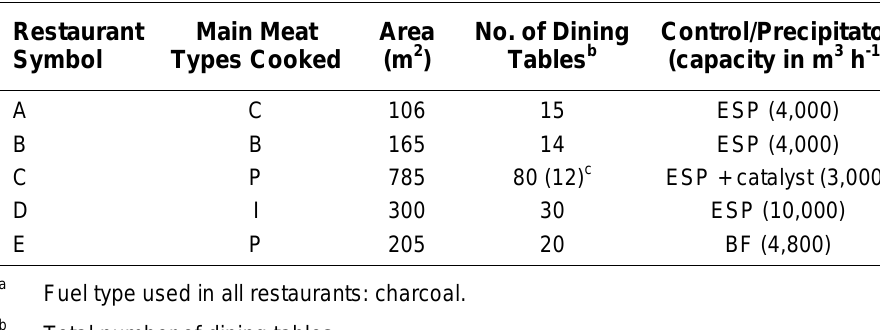
Table 2. Filters were placed in a weighing chamber over 24 h, both before and after sampling, and weighted with a microbalance (UMX2, Mettler Toledo Inc., SWI).